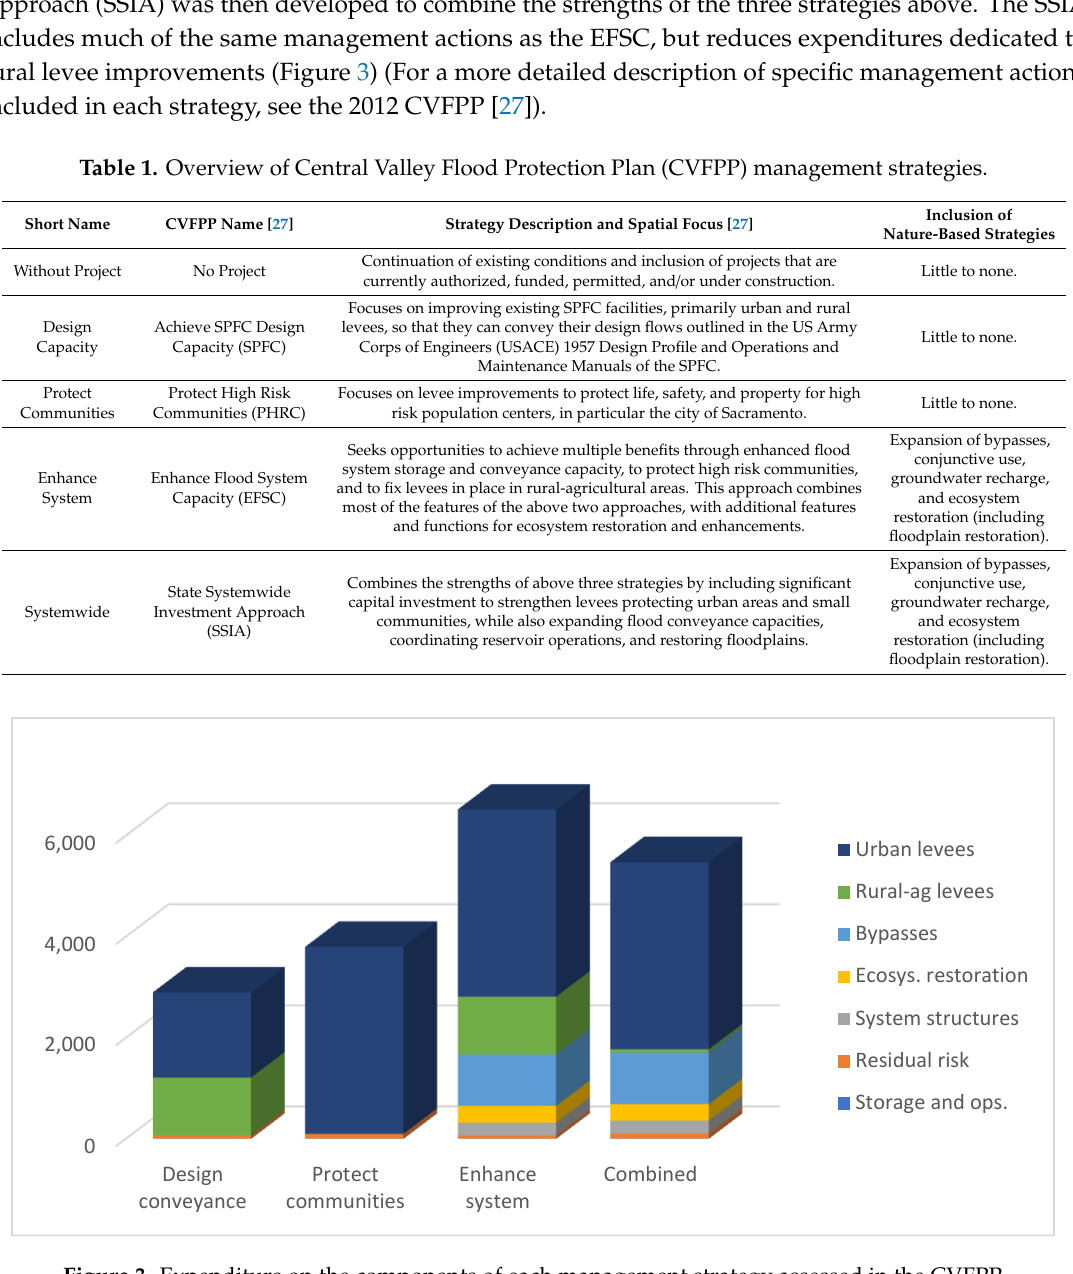
Figure 3. Expenditure on the components of each management strategy assessed in the CVFPP.